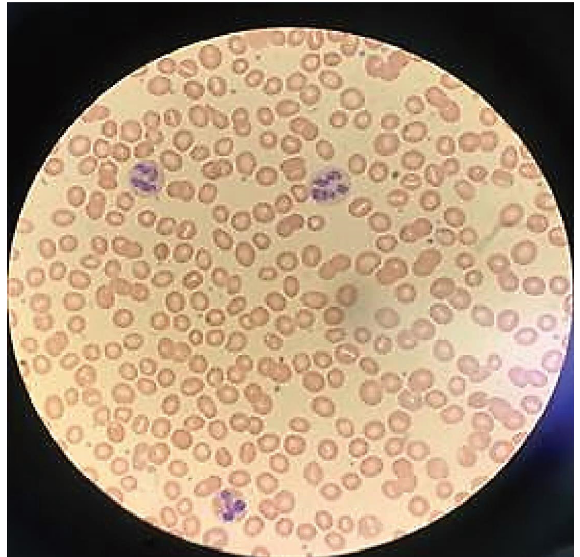
Figure 1: Peripheral smear showing hypersegmented neutrophils consistent with megaloblastic anemia from vitamin B12 defciency.